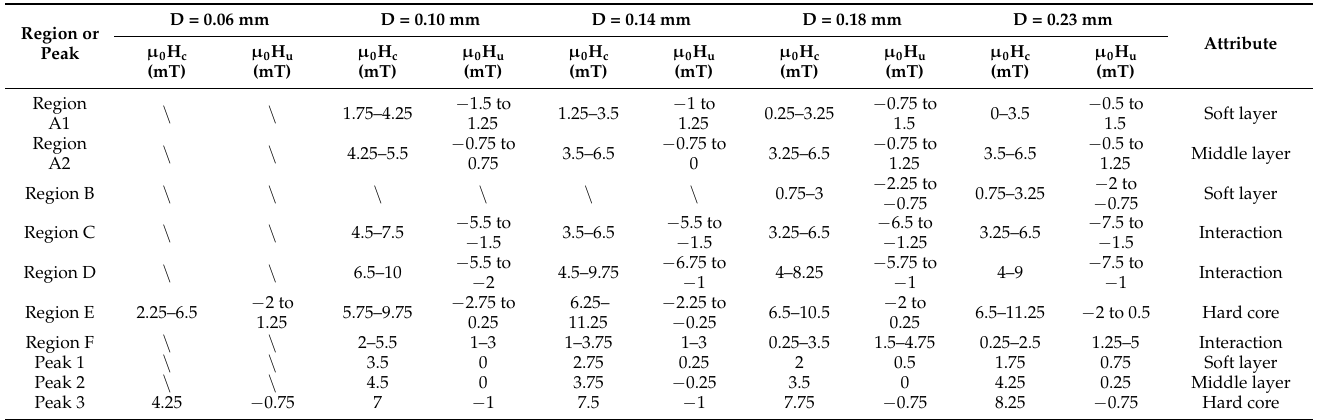
Figure 11. Magnetic structure diagram of 0.10 mm-diameter Wiegand wire. Table 1. Distribution of coercivity and interaction fields in various regions of Wiegand wires with varying diameters.